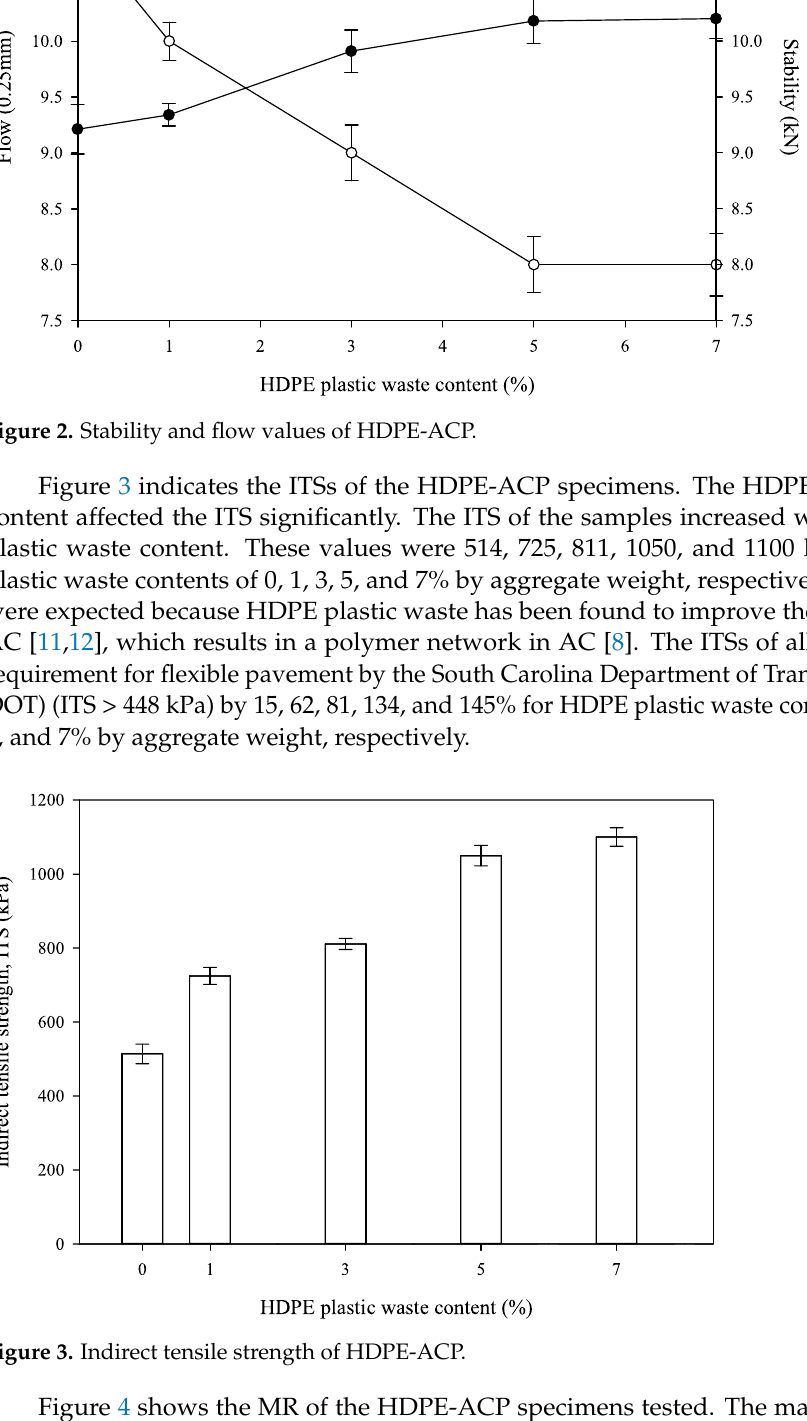
Figure 4. Resilient modulus of HDPE-ACP.